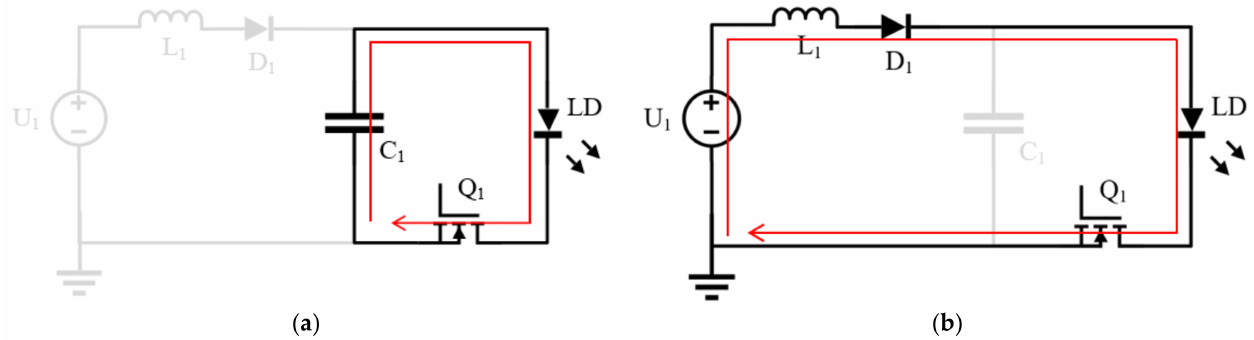
Figure 3. ( a ) Discharging current path during discharging stage; ( b ) DC current path during discharging